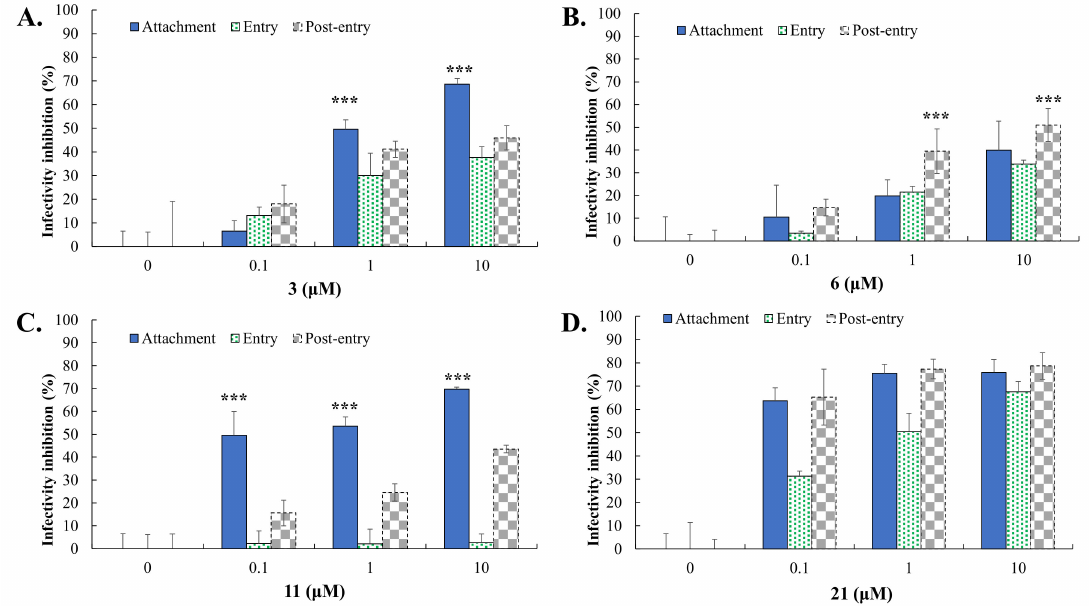
Figure 5. Time-of-addition and removal assay for analyzing antiviral action of compounds 3 ( A ) , 6 ( B ) , 11 ( C ) , and 21 ( D ) in Vero E6 cells. In the attachment mode, cells were pre-cooled and incubated with fresh-prepared mixtures of active compounds with DENV2 at 4 ◦ C for 1 h. After the removal of the mixtures, the cells were kept at 37 ◦ C for 96 h (a cycle of viral replication) and then were performed by immunofluorescent assay plus DAPI staining. In entry and post-entry modes, cells were infected with DENV2 and treated with the compounds simultaneously (the entry stage) or 1-h post-infection (post-entry stage). After a 1 h incubation period, the virus/compound mixture was removed; the cell monolayer was washed with PBS and cultured for 96 h and then subjected to immunofluorescence staining and DAPI. Finally, the inhibition percentage of DENV2 infectivity was calculated as follows: 1-(percentage of NS4B positivity in treated cells/percentage of NS4B positivity in mock-treated cells). *** p < 0.001 compared with the other two antiviral action